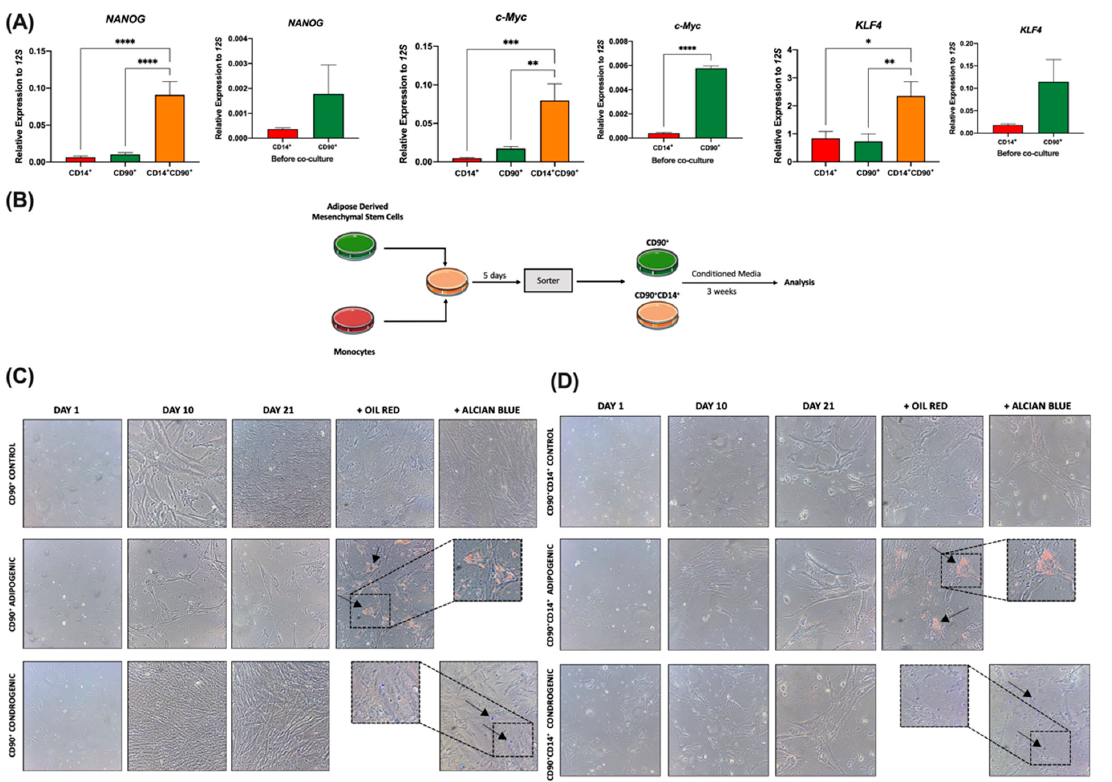
Figure 5. FHCs maintain stemness properties after fusion. ( A ), Main panels, the relative expression of NANOG , c-Myc , and KLF4 genes by RTqPCR of sorted CD14 + human monocytes (red), CD90 + hADMSCs (green), and CD90 + CD14 + FHCs (tangerine) after 5 days of co-culture are shown (n = 9). *, p < 0.05; **, p < 0.01; ***, p < 0.001 and ****, p < 0.0001 in ordinary one-way ANOVA with Tukey’s multiple comparison post-hoc test. (Inserts), the relative expression of NANOG, c-Myc and KLF4 genes of CD14 + human monocytes (red) and CD90 + hADMSCs (green) before co-culture are shown (n = 3). ****, p < 0.0001 in unpaired t test. ( B ), Schematic representation of experimental conditions for cellular differentiation. ( C ), Representative brightfield microscopy images for kinetics of cellular differentiation of CD90 + hADMSCs images at 1, 10, and 21 days at 20x magnification. Oil red was used to confirm adipogenic differentiation and alcian blue to determine chondrogenic differentia- tion. Arrows indicate differentiation areas. ( D ), Representative brightfield microscopy images for kinetics of cellular differentiation of sorted CD90 + CD14 + cells (FHCs) images at 1, 10, and 21 days at 20x magnification. Oil red was used to confirm adipogenic differentiation and alcian blue to deter- mine chondrogenic differentiation (n = 3). Arrows indicate differentiation areas.